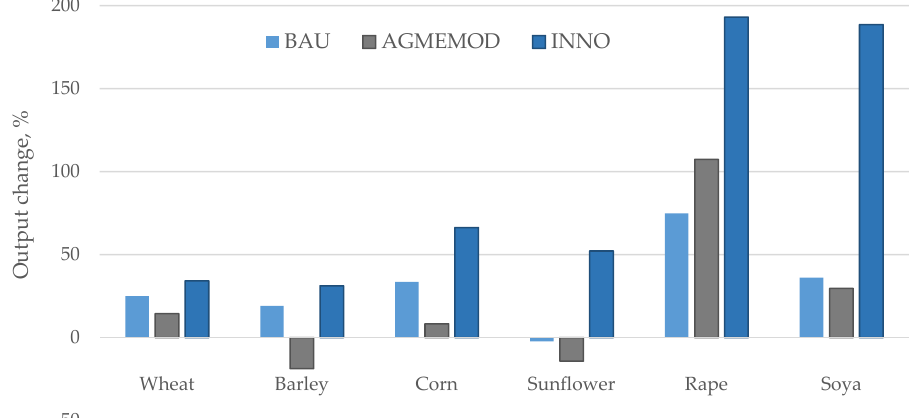
Figure 4. Wheat and corn crop yields: comparison of available statistical data and projections obtained with the AGMEMOD model. Source: own compilation based on [51], verified against [39].